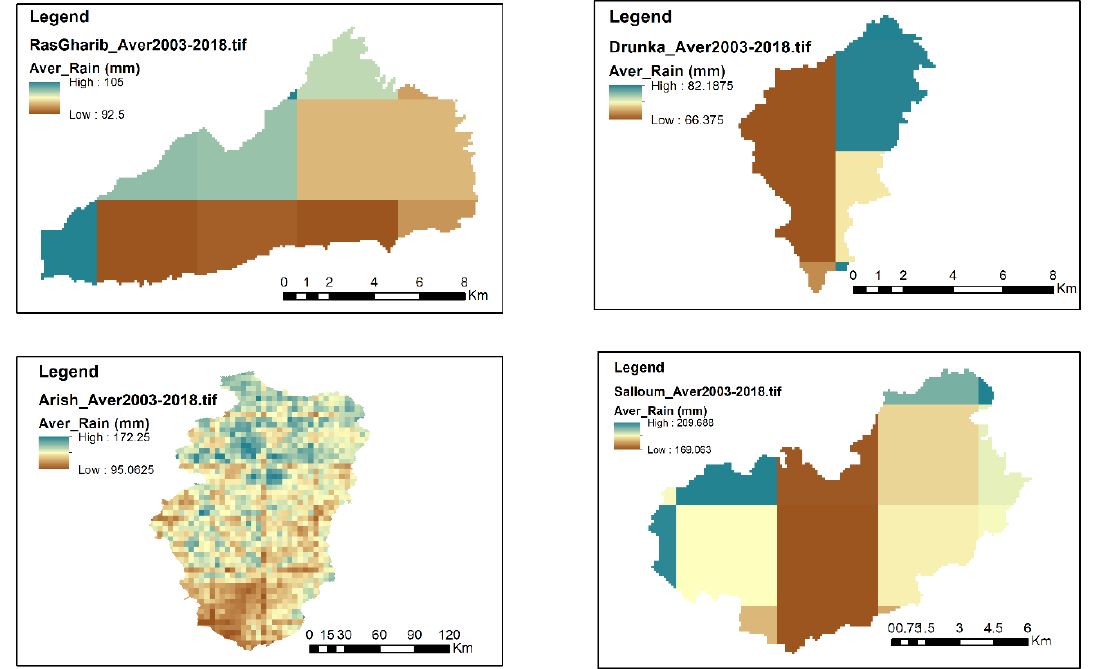
Figure 8. Spatial map showing the total rainfall average (2003 to 2018) using the PERSSIAN-CDR long-term rainfall data over the four selected regions and Egypt.